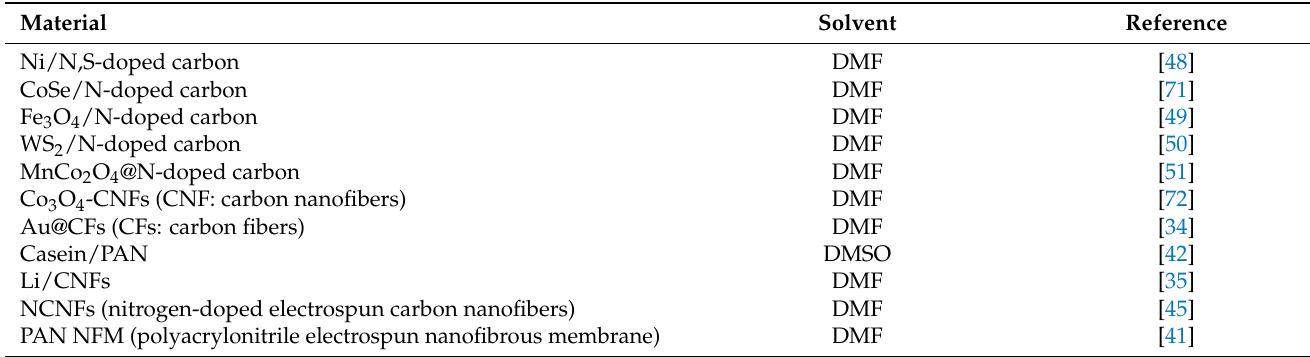
Table 2. Different types of materials prepared as fibers with PAN via